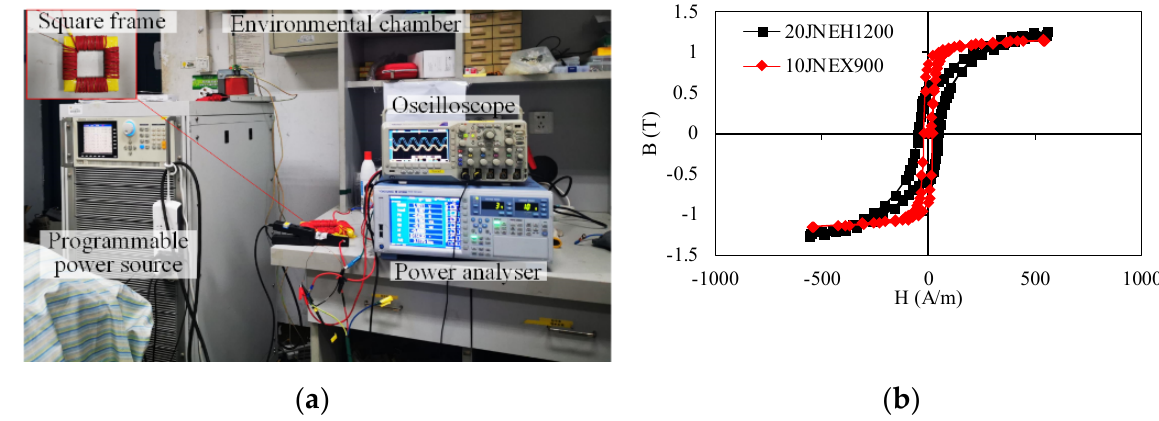
Figure 4. AC measurement system for soft magnetic materials. ( a ) Test platform and ( b ) magnetizing characteristics of the silicon steel sheet.